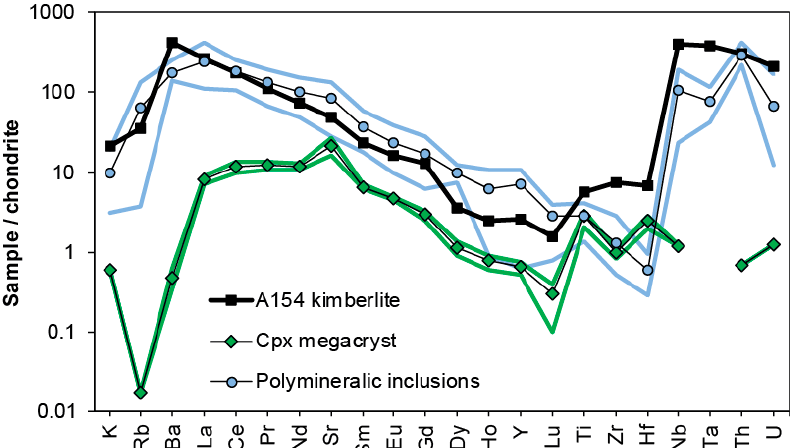
Figure 4. Chondrite-normalized (using the values by McDonough and Sun [69]) trace-element patterns of reconstructed bulk compositions of polymineralic inclusions within Diavik clinopyroxene (Cr-diopside) megacrysts compared to the pattern of the host A145N kimberlite [70]. Average concentrations for polymineralic inclusions were calculated from the data by van Achterbergh et al. [47,48] and Araújo et al. [49]. Average concentrations for clinopyroxene megacrysts were calculated from the data by van Achterbergh et al. [47,48] and Bussweiler et al. [42]. The shaded fields indicate the range between minimum and maximum values for a given element.